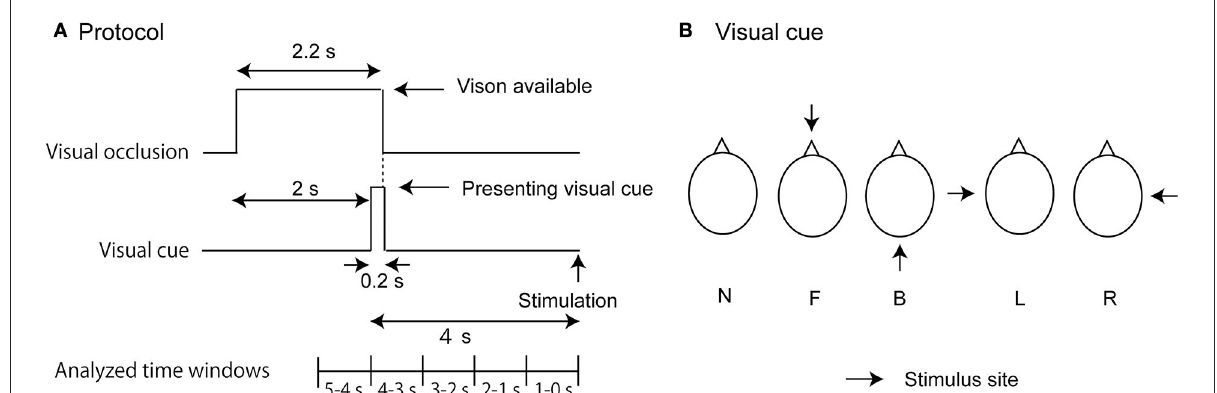
FIGURE1 Experimental design. The time protocol in each trial is shown in (A) . Visual cues indicating a bird’s-eye view of the stimulus site are shown in (B) . In (B) , each abbreviation indicates the stimulus condition: L, L condition (cue predicting the stimulus to the left side of the head); R, R condition (cue predicting the stimulus to the right side of the head); F, F condition (cue predicting the stimulus to the forehead); and B, B condition (cue predicting the stimulus to the back of the